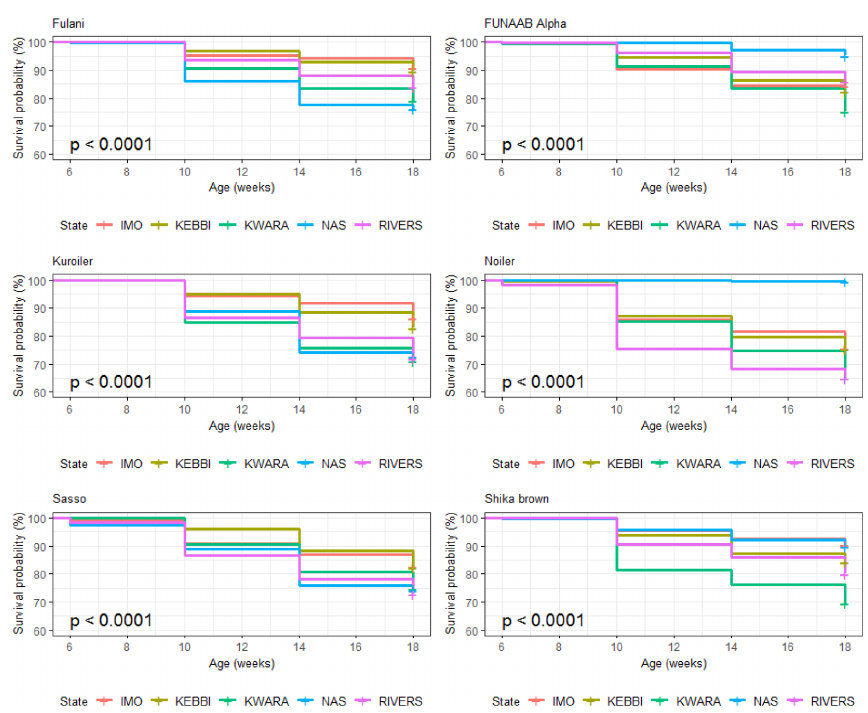
Figure 12. Breed by environment interaction on overall survivability of birds (breeds) during growing phase in ACGG Nigeria project zones (6–18 weeks) (2016–2017).